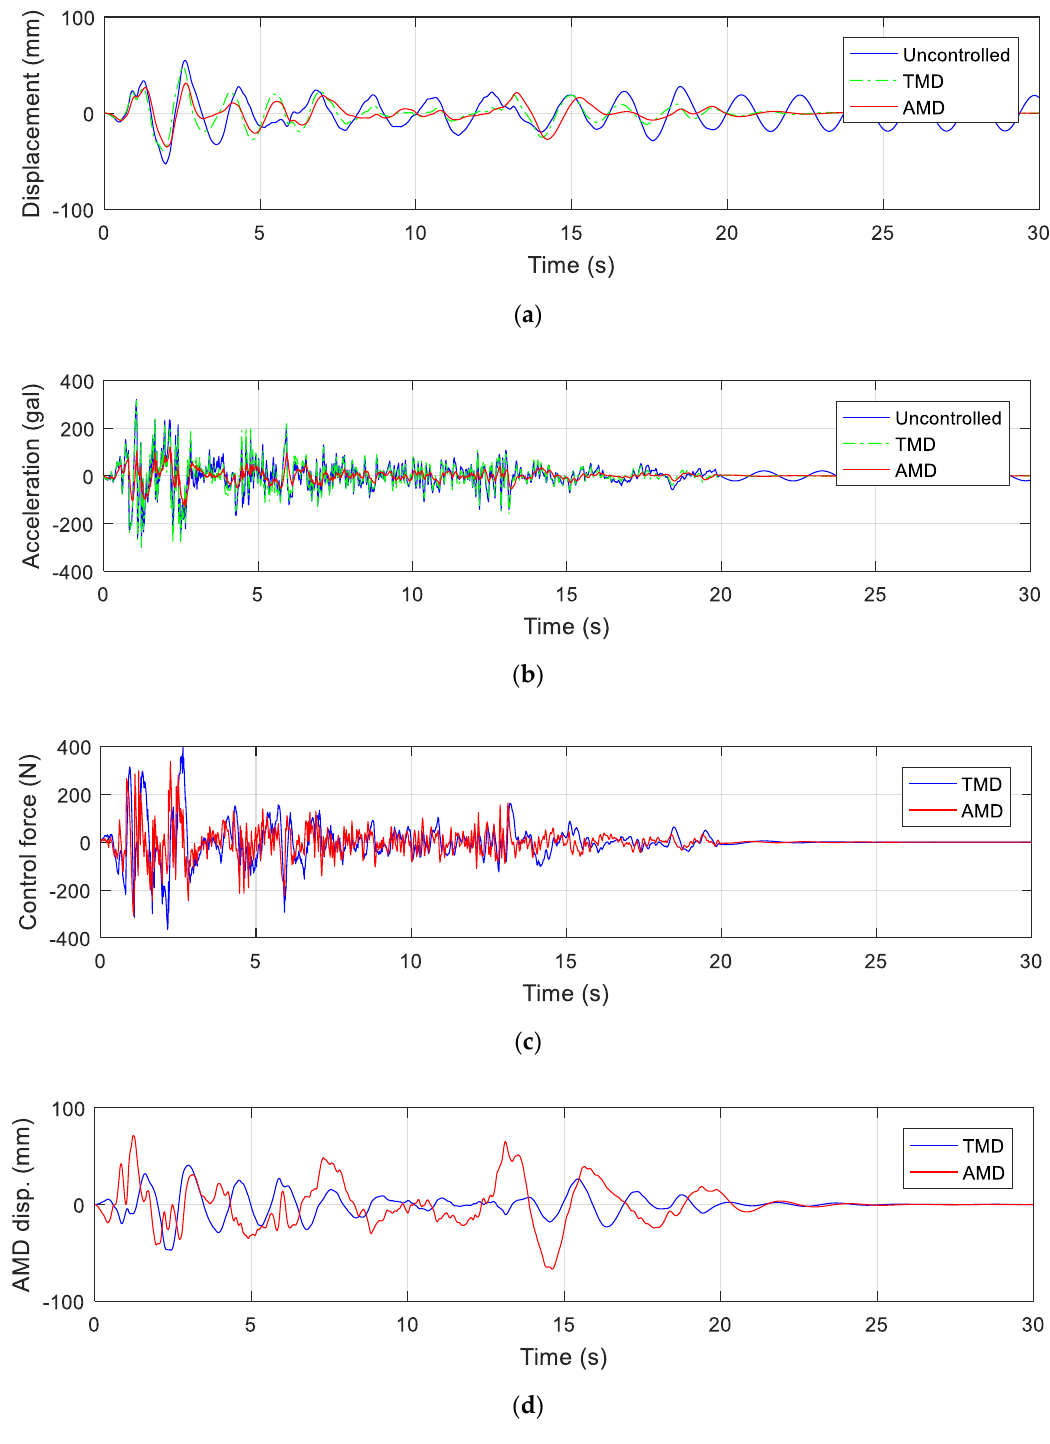
Figure 15. Analytical results with the El Centro earthquake: ( a ) bridge displacement, ( b ) bridge acceleration, ( c ) AMD force, and ( d ) AMD displacement.